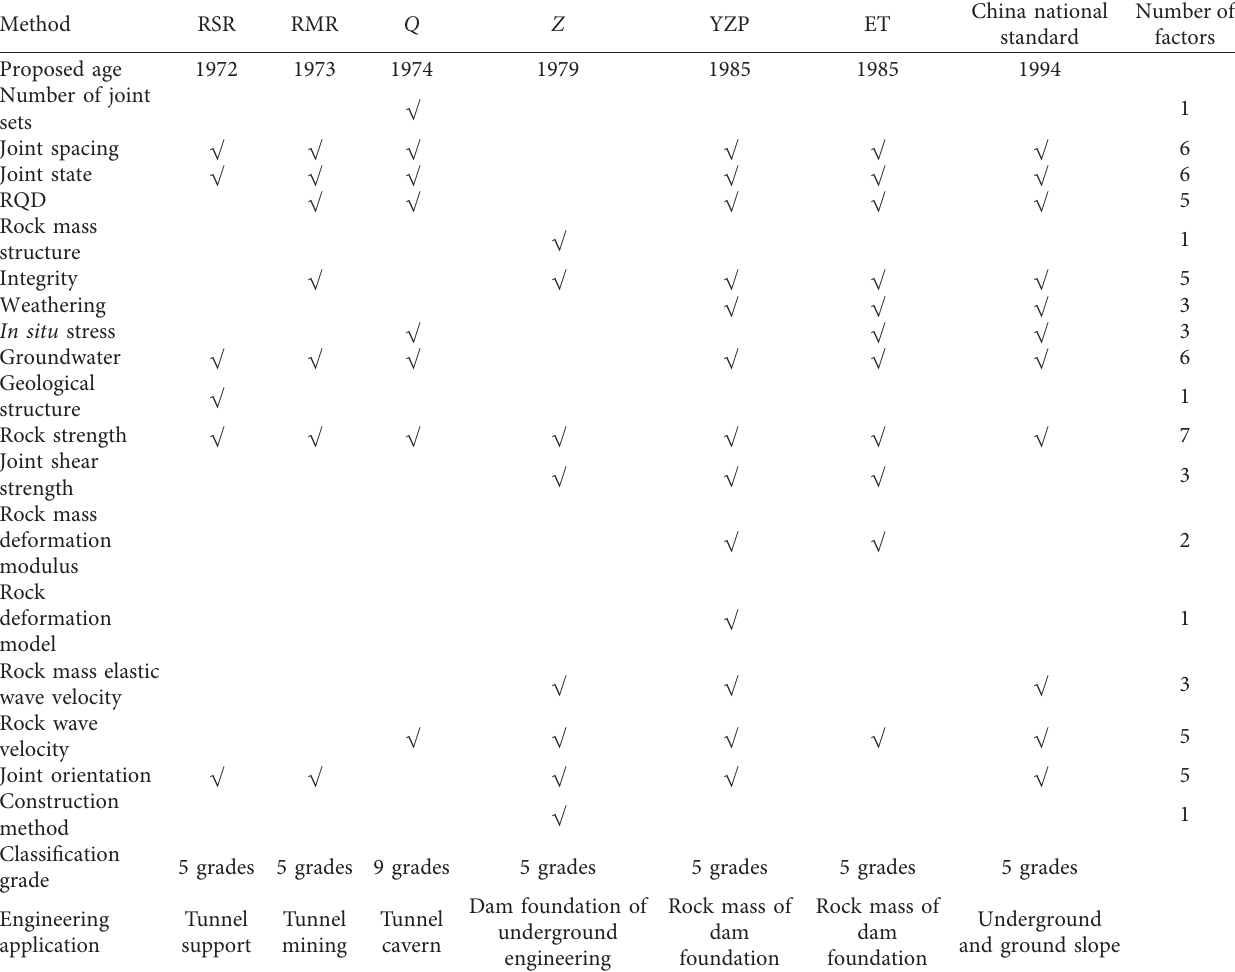
Table 1: A list of influencing factors considered in typical rock mass classification methods.